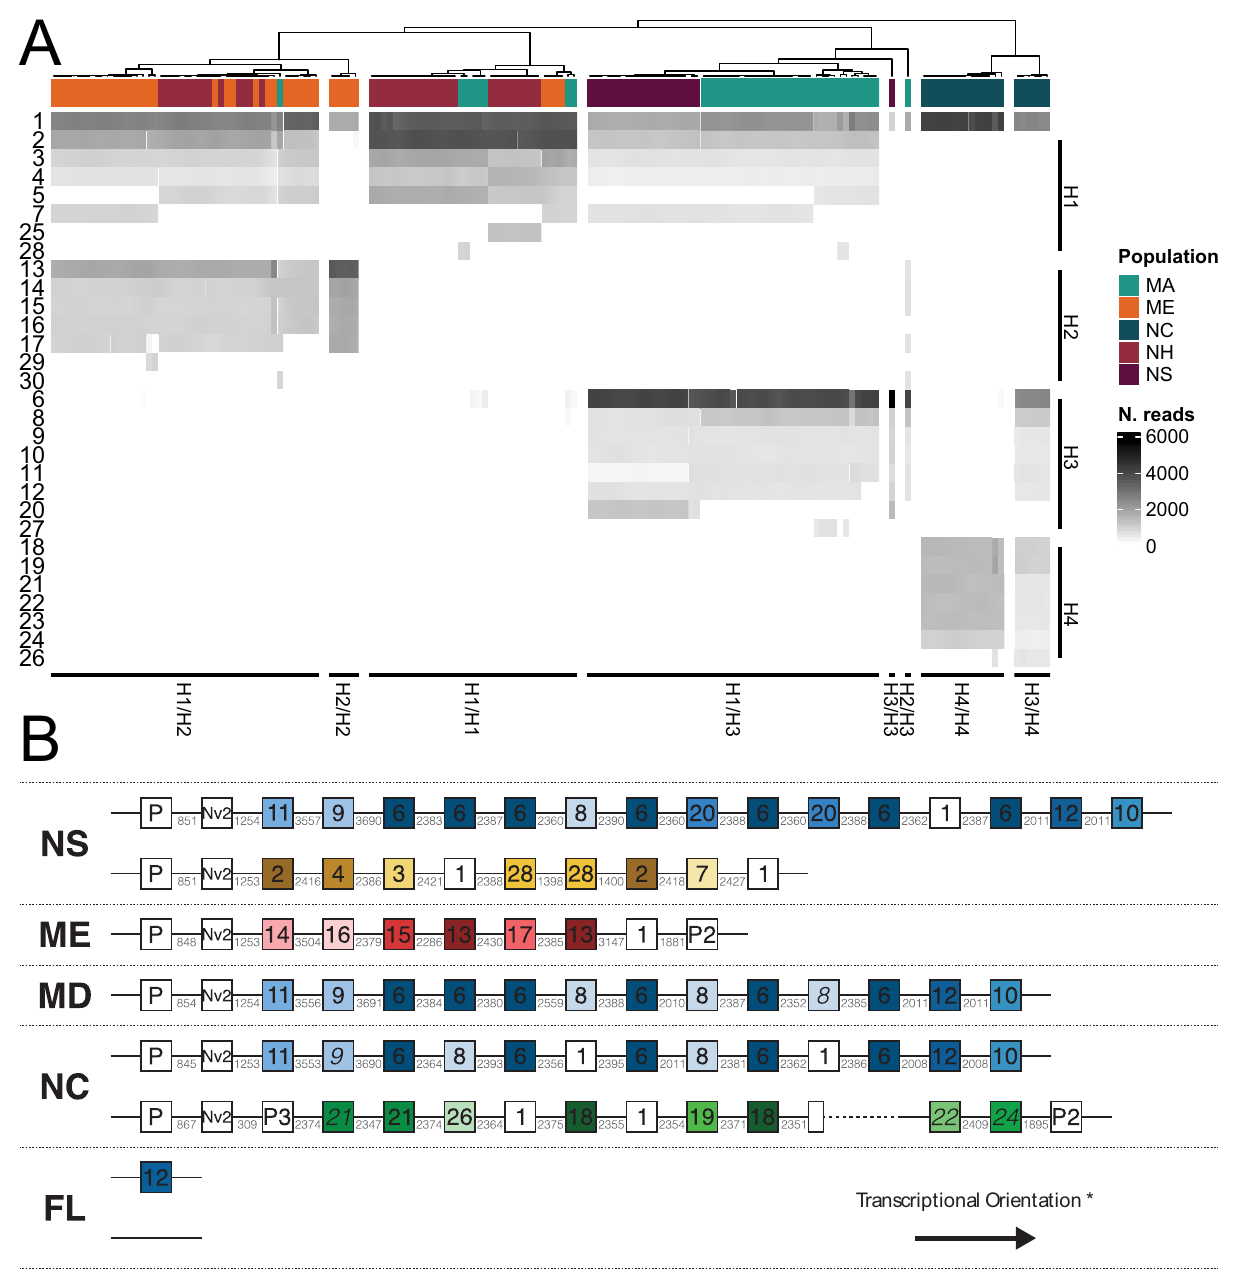
Fig.5|Genomicarrangementof Nv1 loci.A Heatmapof Nv1 paralogabundancein N. vectensis samples. Samples are clustered along the x axis according to Nv1 composition and labeled according to the sampled population. Nv1 paralogs are grouped on the y axis according to the inferred haplotype (H1 – 4). B Genomic arrangement of the Nv1 locus across individuals Each box denotes an Nv1 paralog with the internal label corresponding to the numeric identi fi er of the associated amplicon variant. Paralogs are colored according to the corehaplotypes identi fi ed in the amplicon analyses (Yellow=H1, Red=H2, Blue=H3, Green=H4, White=